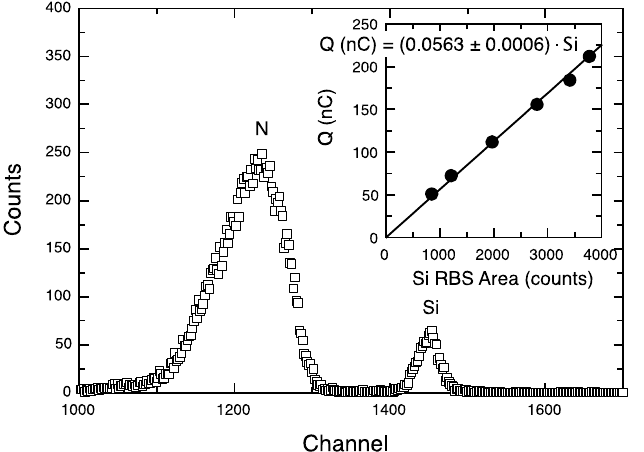
Figure 7. RBS spectrum of 2.5 MeV protons backscattered from Si and N in a 500 nm thick silicon nitride extraction window for beam normalization purposes. In the inset, a correlation between the area of the Si RBS peak and the integrated beam charge.